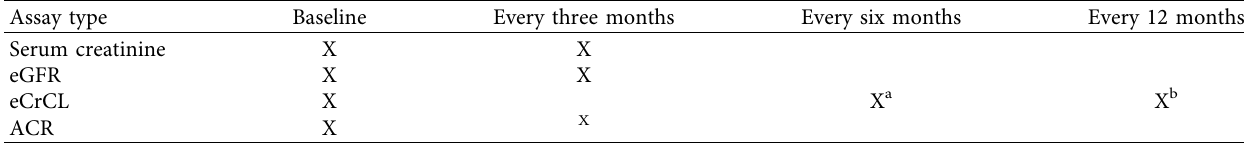
Table 1: Laboratory assessments [80,